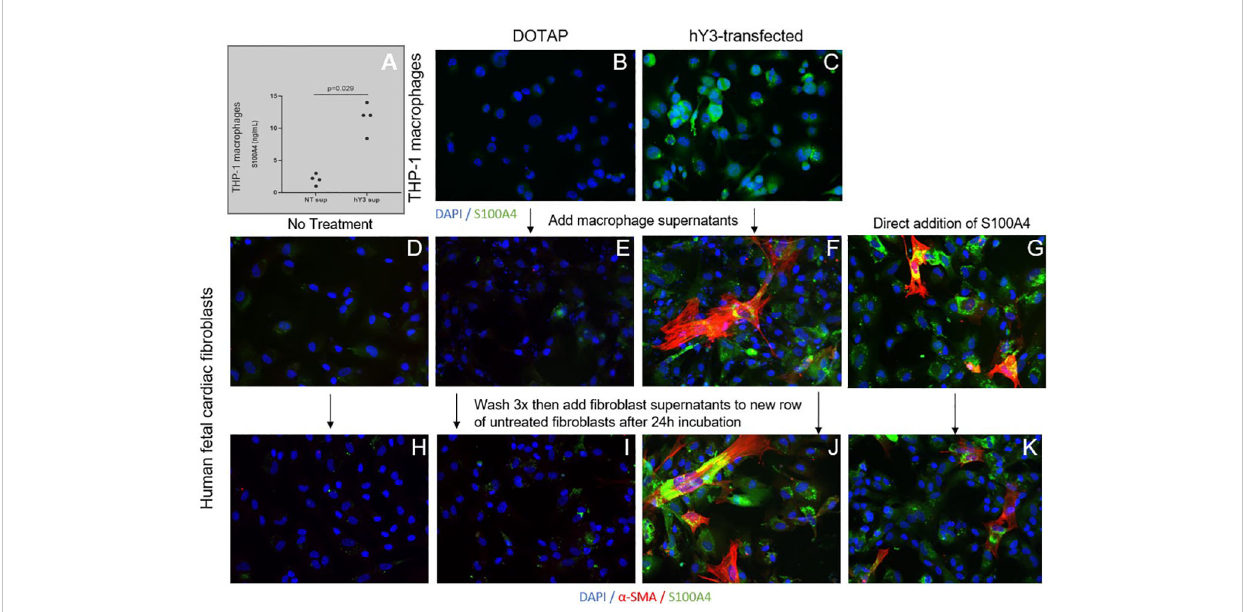
FIGURE 6 In fl uence of hY3-transfected macrophages and hY3 sup exposed- fi broblasts on surrounding cells. Evaluation of S100A4 in the supernatants of untreated macrophages (NT sup) and macrophages transfected with hY3 (hY3 sup) was performed using a speci fi c enzyme-linked